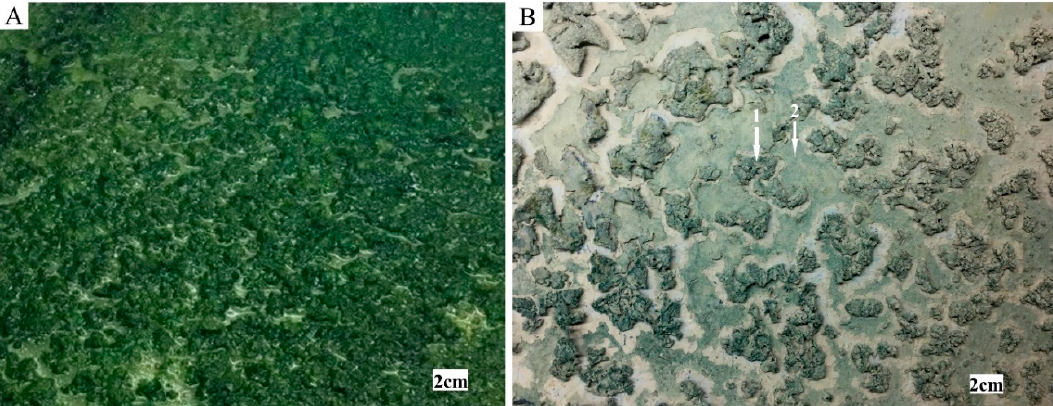
Figure 3. Formation of biocrusts. The interaction between the cyanobacterial biofilm ( A ) and particles resulted in biocrust development ( B ). A patchy structure was formed by pinnacled and curled biocrusts ( B , arrow 1). Smooth biocrusts appeared between the patches later ( B , arrow 2).